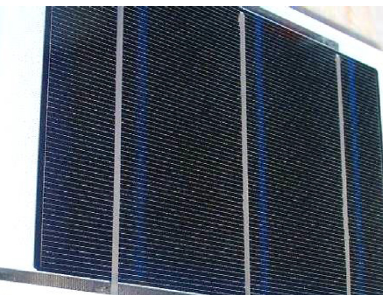
Fig. 2. Photograph of an irradiated mini module with empha- sized LCR effect (blue lines beside LCRs).